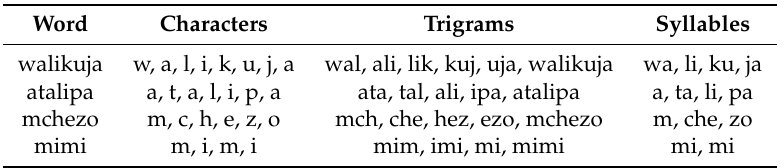
Table 5. Comparative analysis of how Swahili words are split when characters, trigram and syllables are used as compositional components. The first two are verbs with subject prefix, tense prefix and root while the last two are noun and pronoun,